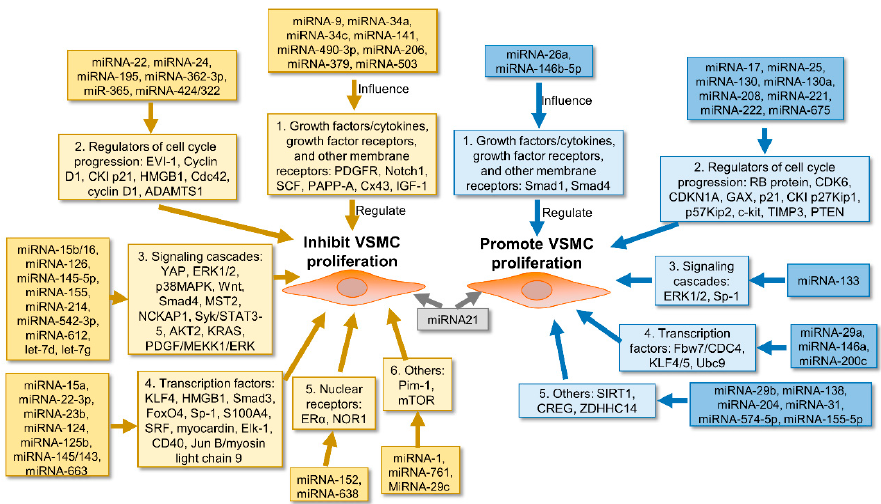
Figure 1. The role of miRNAs in the regulation of vascular smooth muscle cell (VSMC) proliferation.